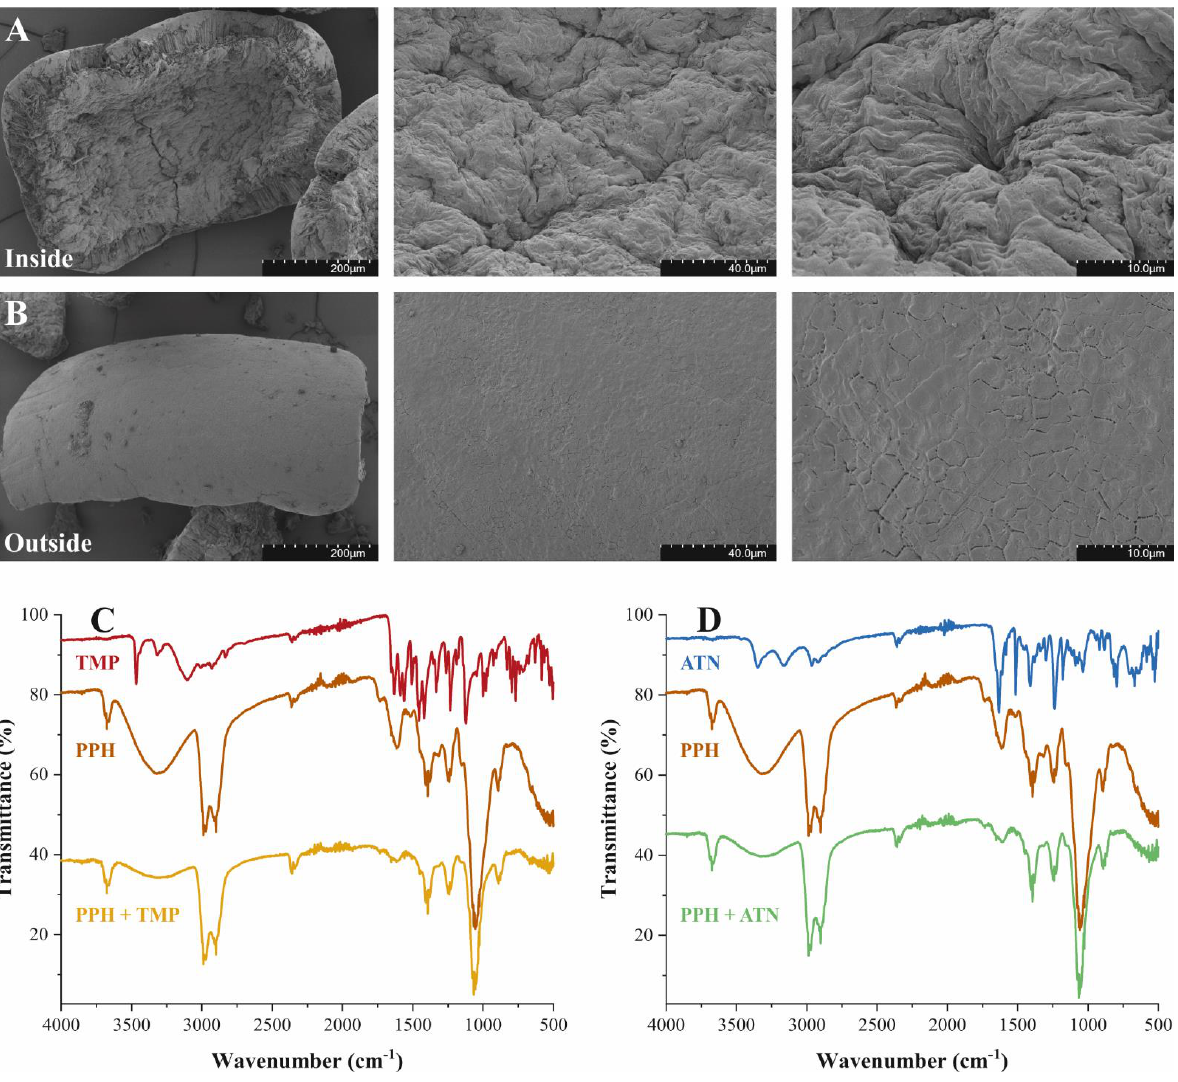
Figure 1. Representative SEM micrographs. ( A ) inside of PPH; ( B ) outside of PPH, at a series of magnifications. ( C , D ) FTIR spectra of TMP ( — ), ATN ( — ), PPH ( — ) and after adsorption of TMP ( — ) or ATN ( — ) on PPH.